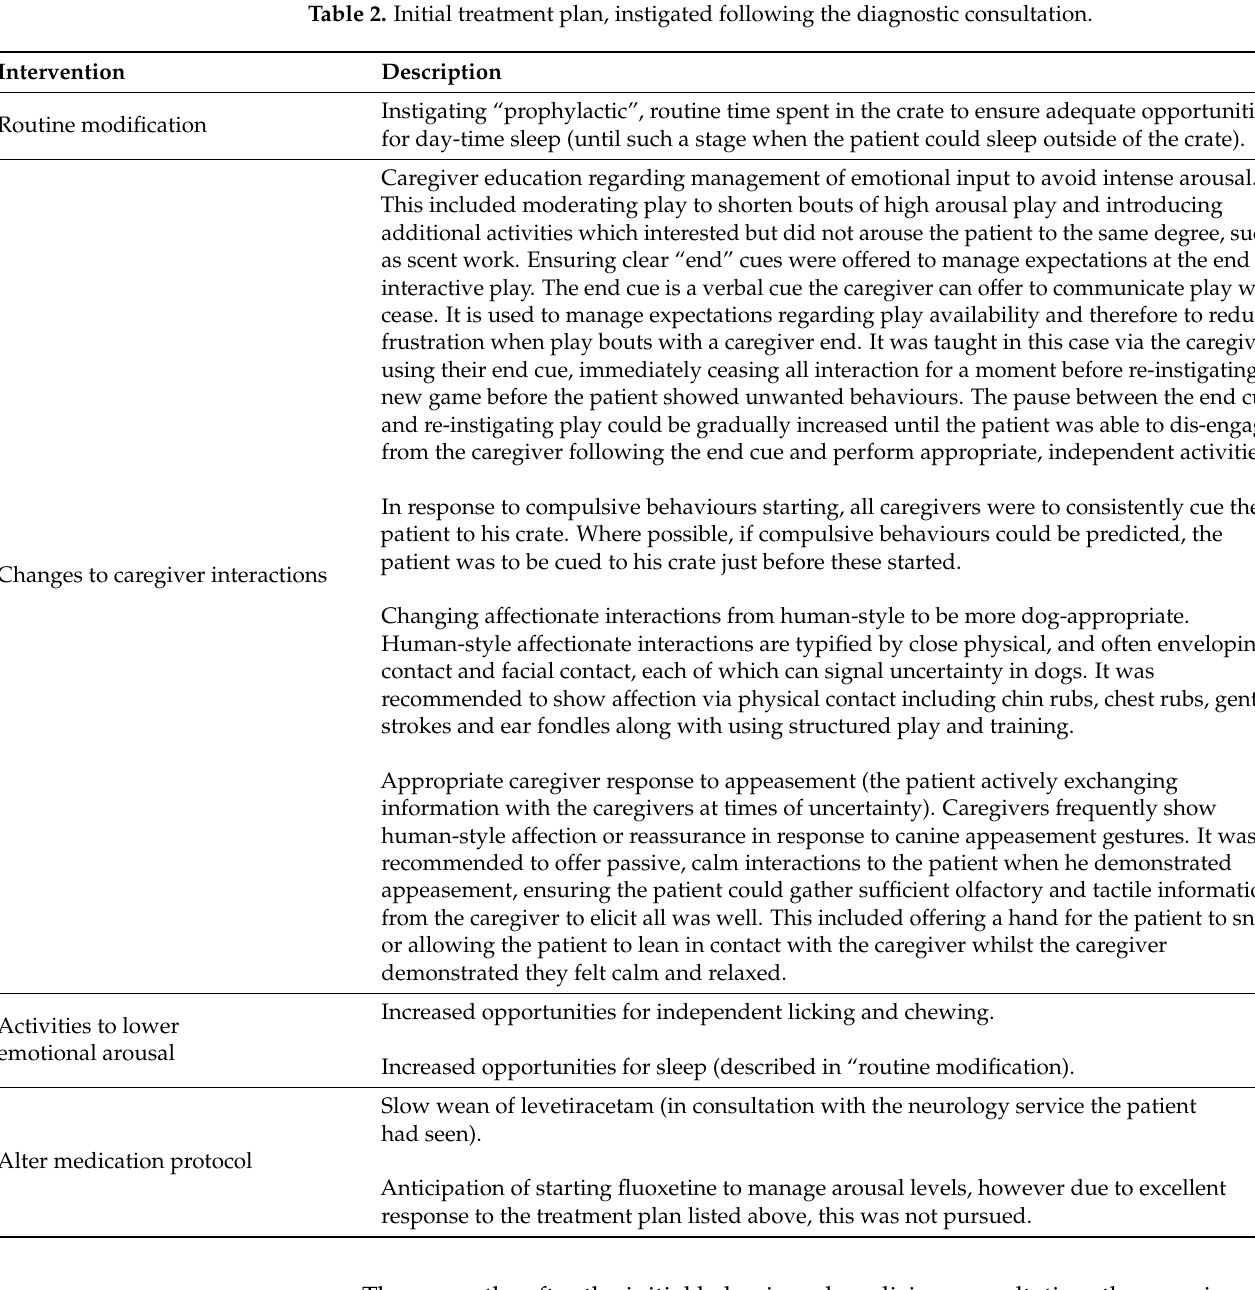
Table 2. Initial treatment plan, instigated following the diagnostic